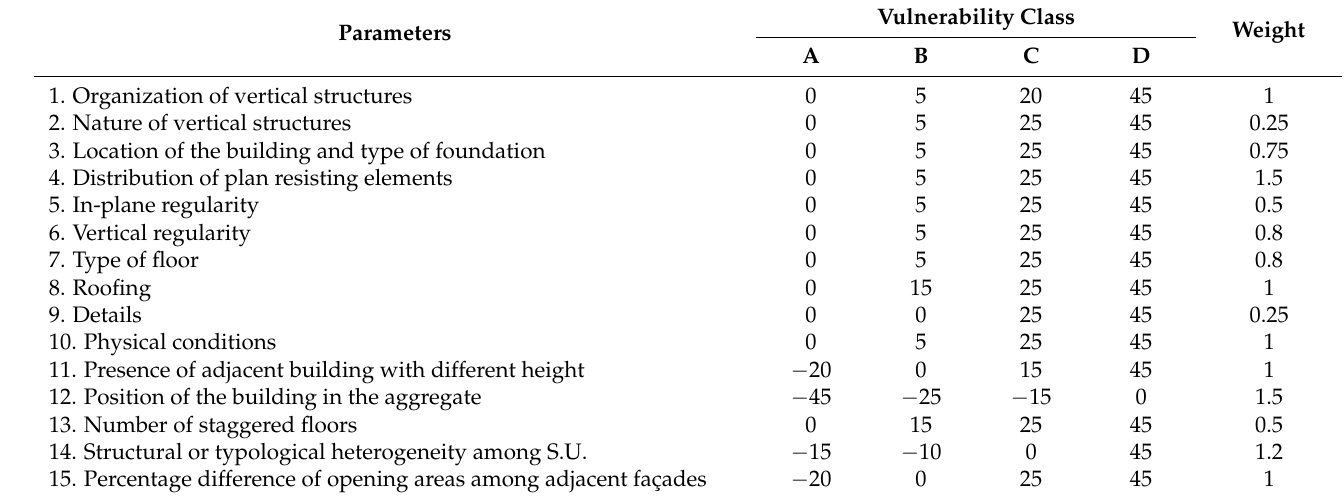
Table 2. Vulnerability form for historical aggregate